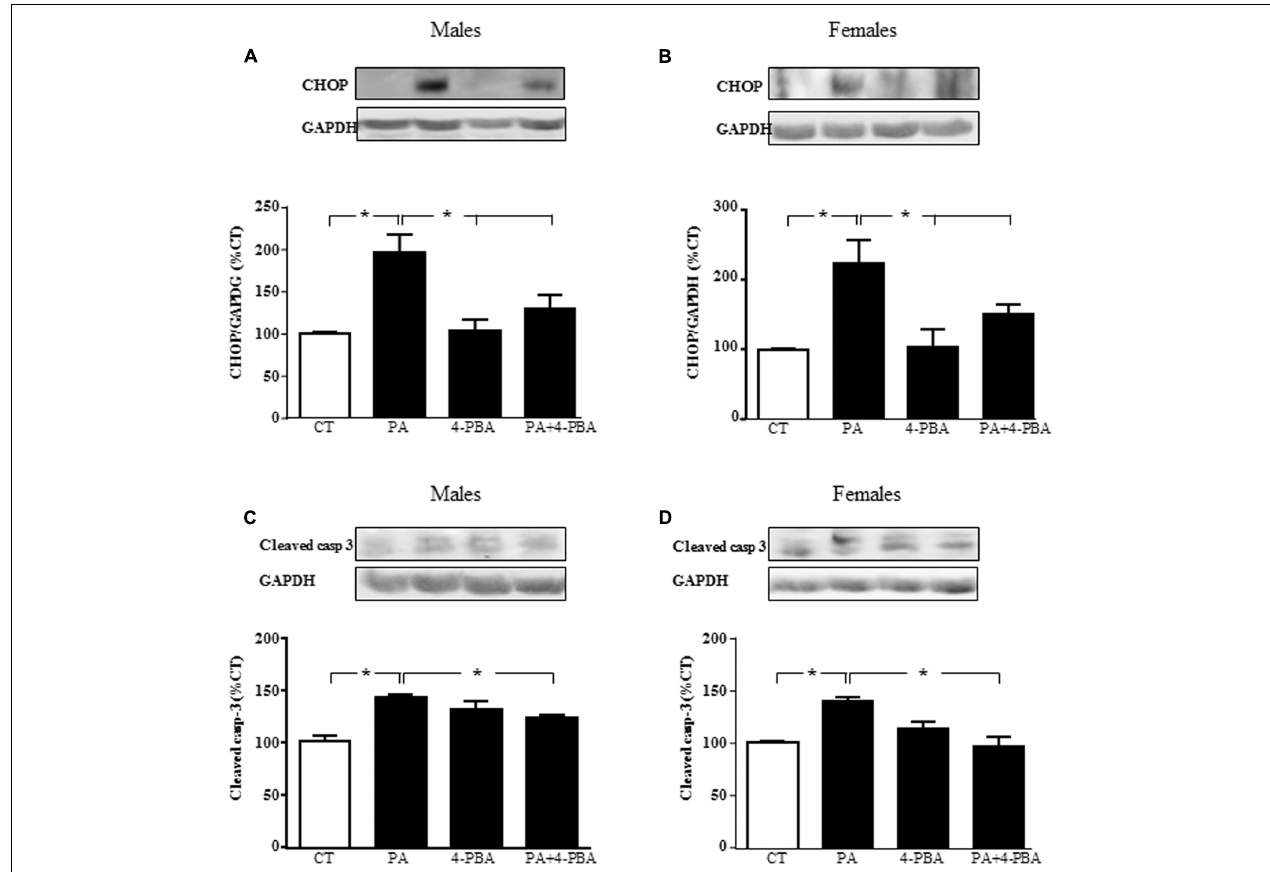
FIGURE 9 | Effects of PA and 4-phenylbutyrate (4-PBA) on C/EBP homologous protein (CHOP) and cleaved caspase-3 protein levels. Astrocyte cultures were treated with PA (0.5 mM), 4-PBA (5 mM) or the combination of both. Immunoblots were probed with antibodies toward cleaved caspase-3 levels (cleaved casp-3) in male (A) and female (B) astrocyte cultures; and CHOP in males (C) and females (D) . The average of three independent assays performed in duplicate is shown. Statistical significance: ∗ p <